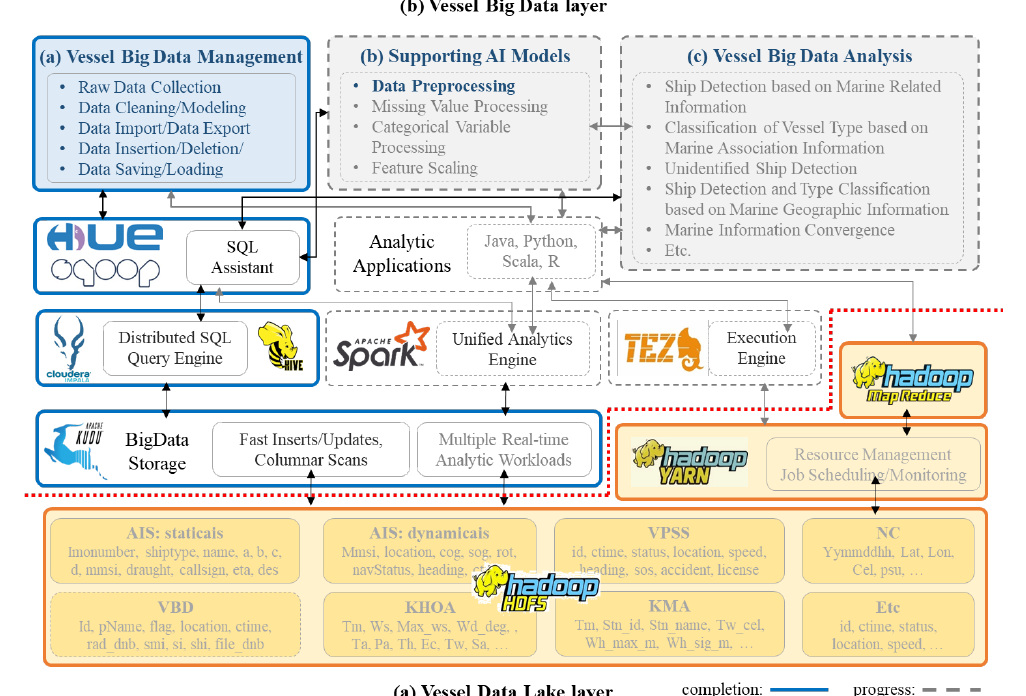
Figure 3. Open Source Software stack of Vessel Big Data layer.